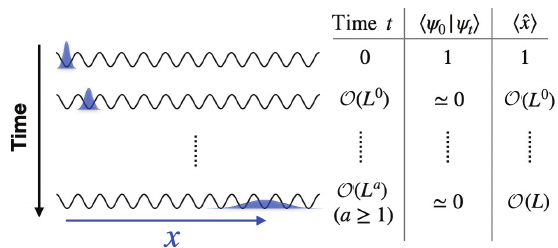
FIG. 2. A simple example of a process with a macroscopic transition. For a single particle at the left end ( (cid:3)ˆ x (cid:4) = 1) to relax to the extended region [ (cid:3)ˆ x (cid:4) = O ( L ) ] on a one-dimensional lattice with size L , it takes at least time t = O ( L a ) ( a ≥ 1 ) . On the other hand, the bound in inequality (1) is loose and cannot capture this timescale, since the time-evolved state can be nearly orthogonal to the initial state even for short times with t = O ( L 0 )